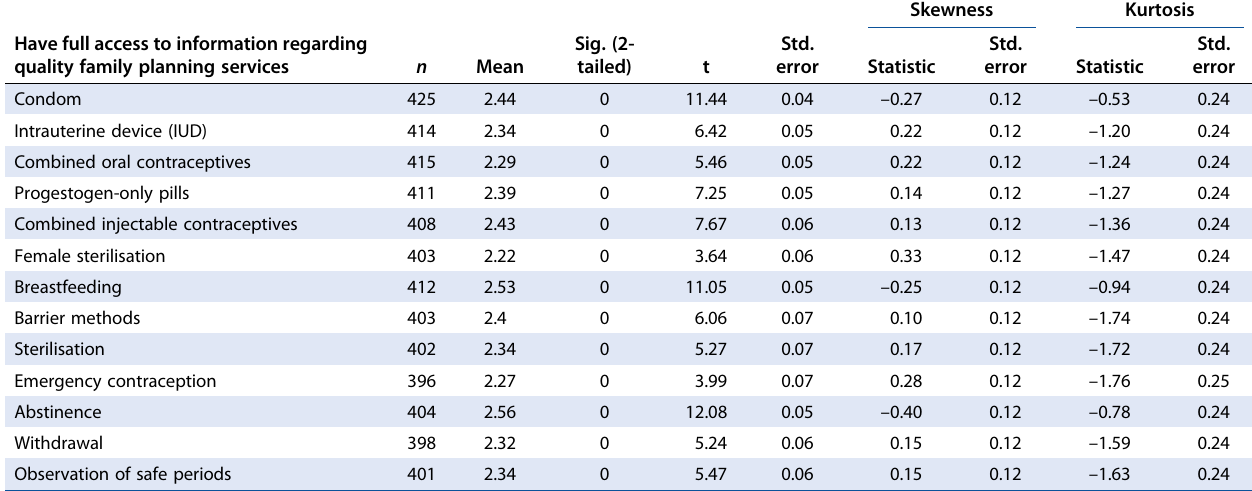
Table 2: Access to information on family planning methods